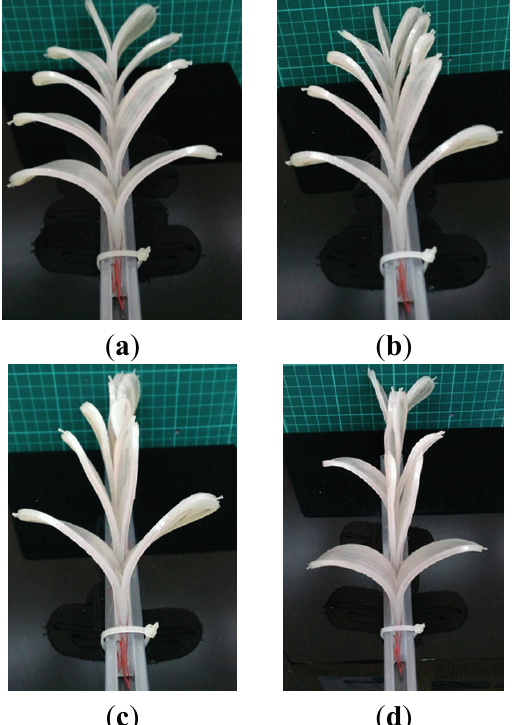
Figure 17. Mimosa system display Modes: ( a ) Mode 1; ( b ) Mode 2; ( c ) Mode 3; and ( d ) self-defined